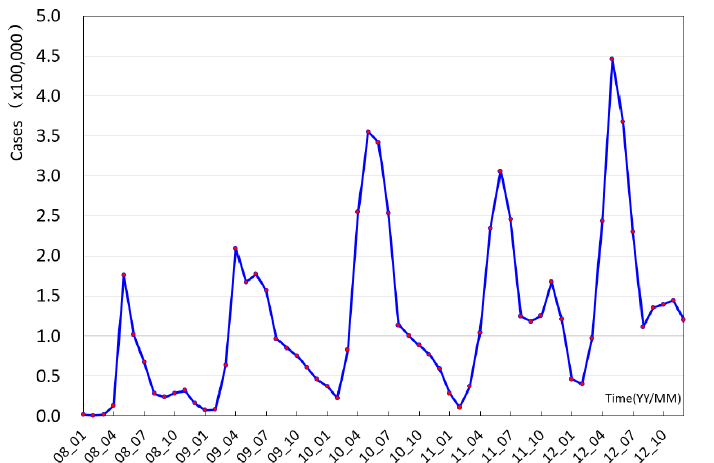
Fig 1. Monthly number of HFMD cases reported in mainland China, 2008 –